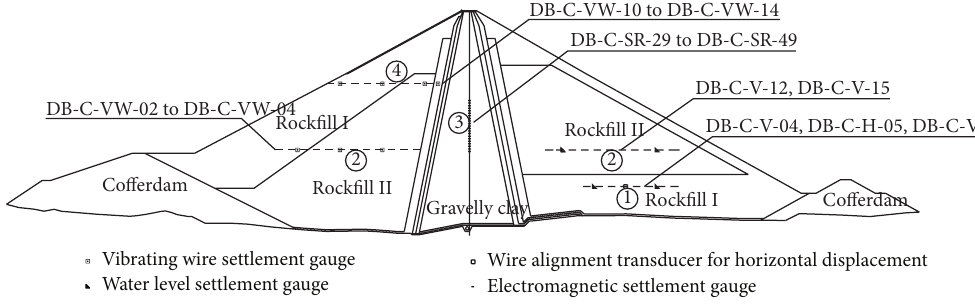
Figure 8: The measurement points used in the 2nd back-analysis.